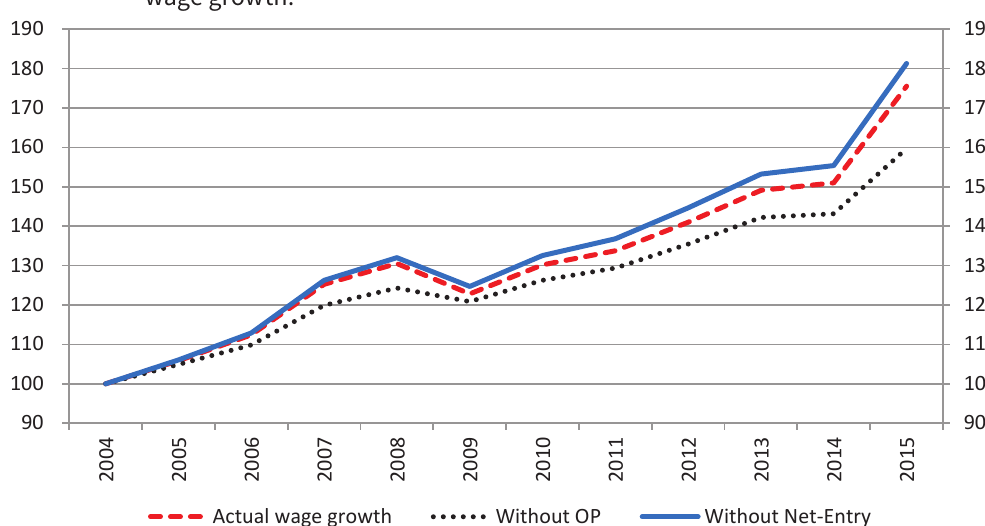
Figure A6 Dynamic OP decomposition and contribution of OP and net entry to aggregate wage